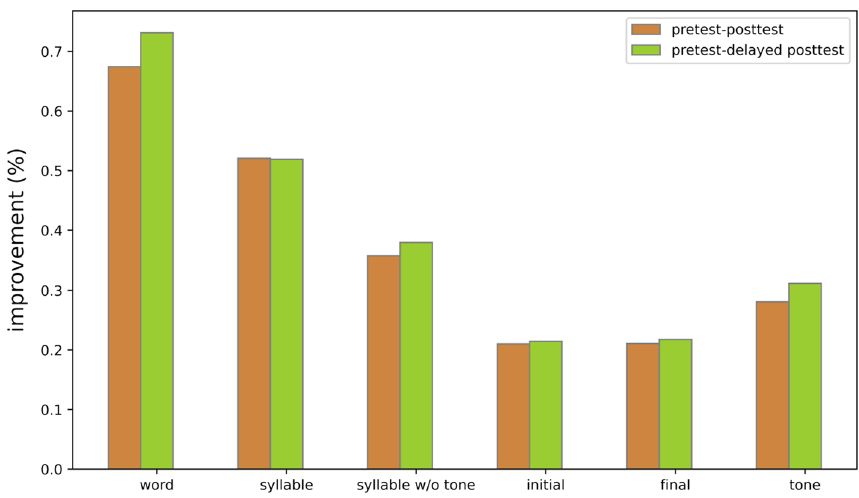
Fig. 6 Overall learning improvement among beginning learners through the Pinyin